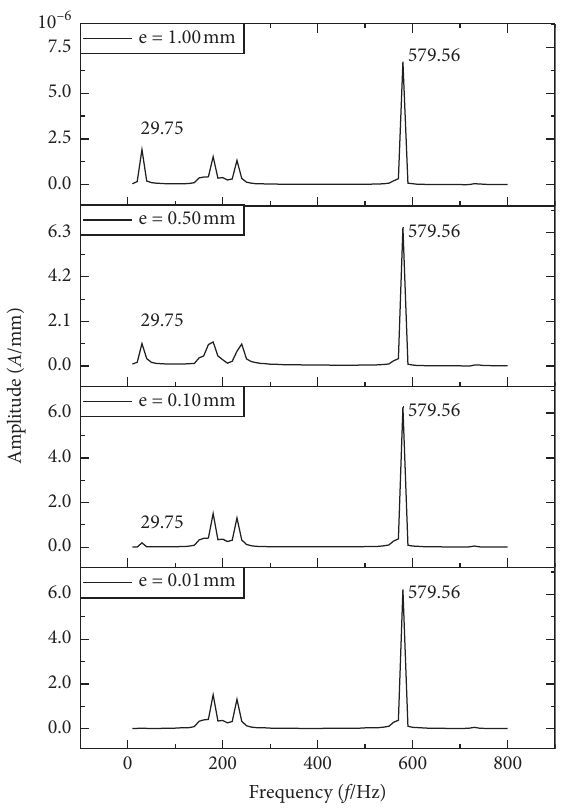
Figure 6: Spectrum diagram under different eccentricity with f